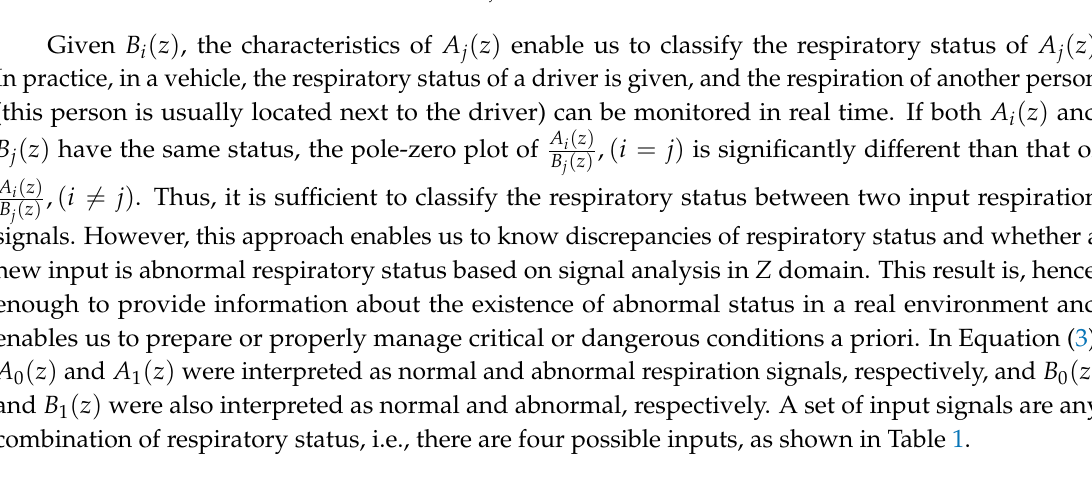
Table 1. Notations used to categorize respiratory